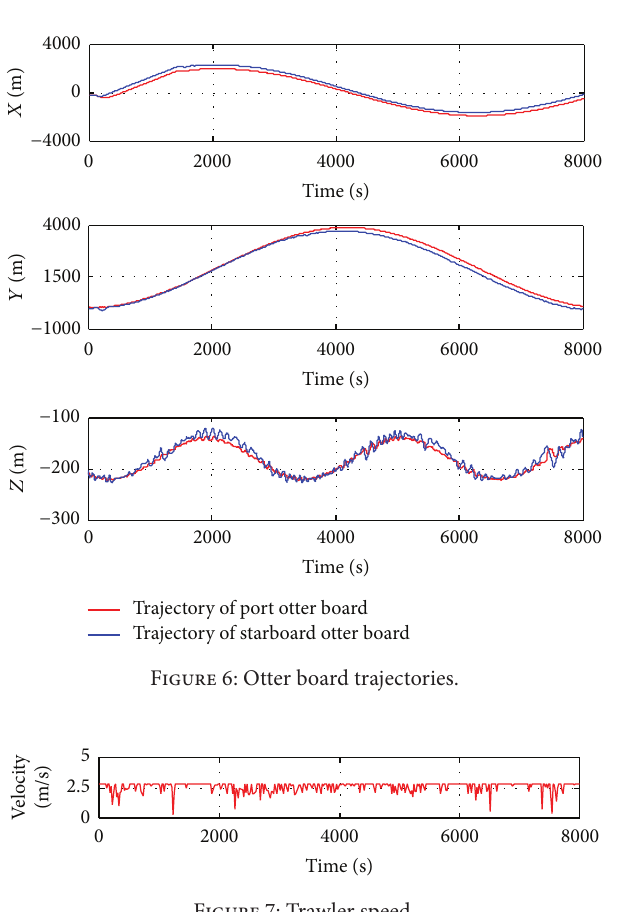
Figure 7: Trawler speed.